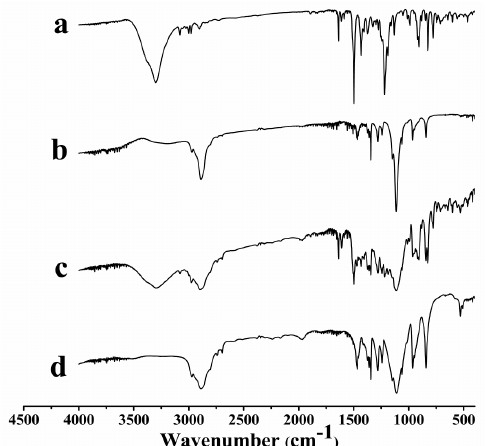
Figure 4. FTIR results (wavenumbers: 400–4000 cm − 1 ) of the samples: ( a ) free HK; ( b ) HK–PLX (1:4) solid dispersion (SD); ( c ) physical mixture (PM) of HK and PLX; ( d ) PLX.